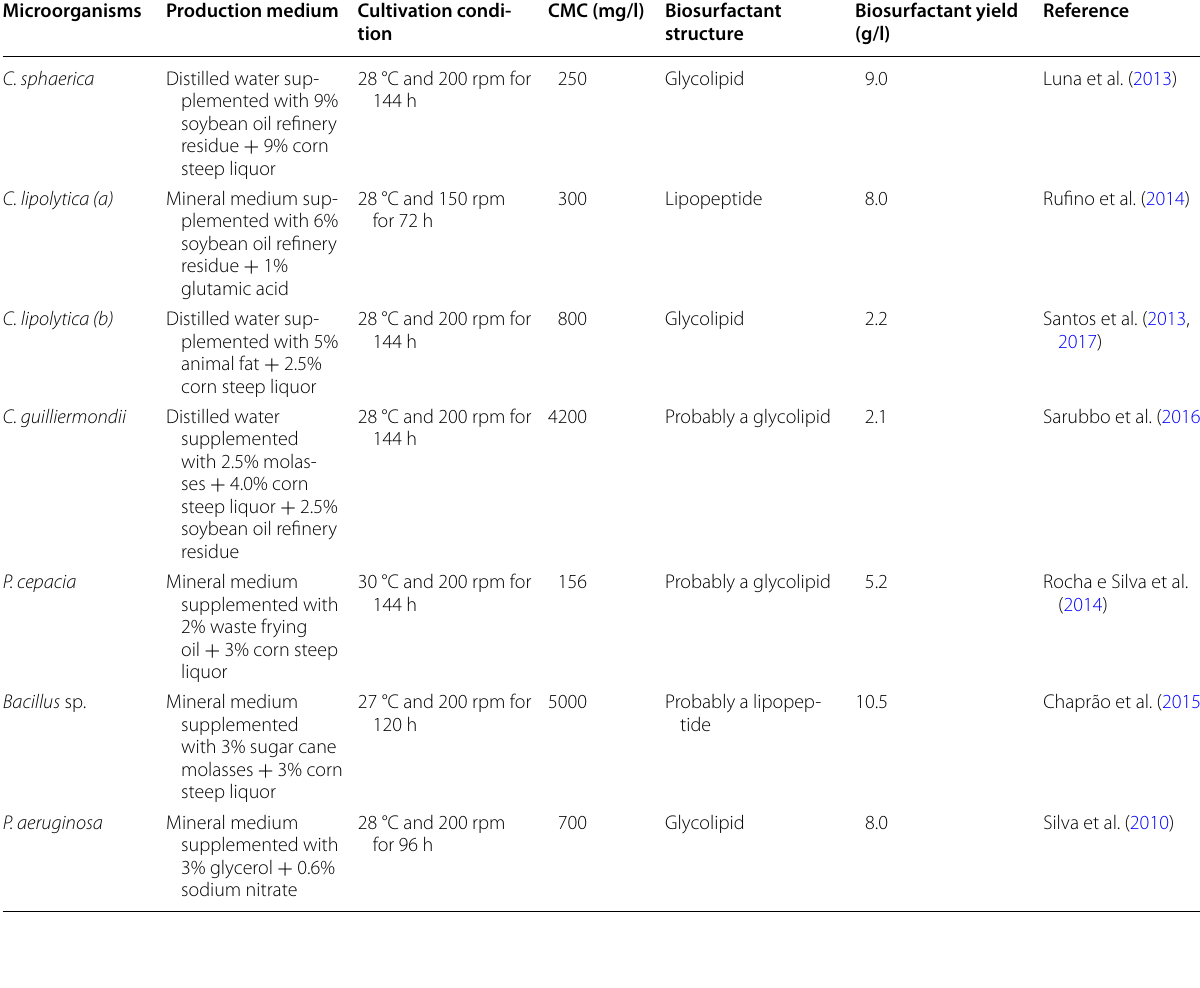
Table 1 Production media, cultivation conditions, CMC, yields, structures and references of the biodemulsifiers tested Microorganisms Production medium Cultivation condi‑